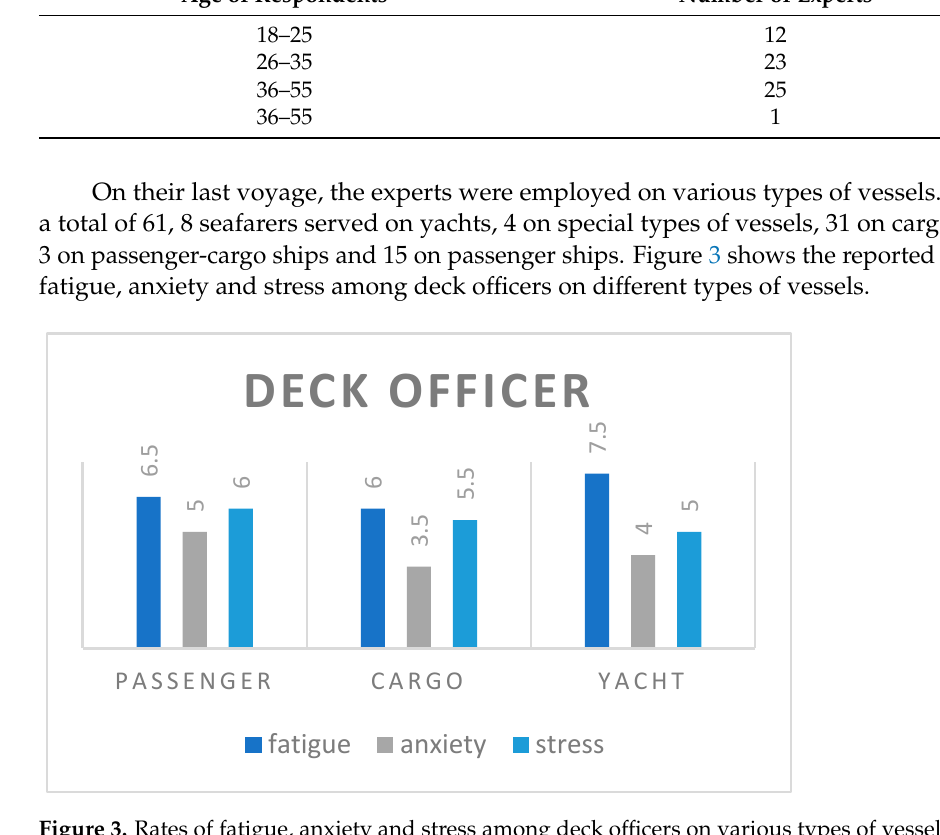
Table 1. Age of the respondents.